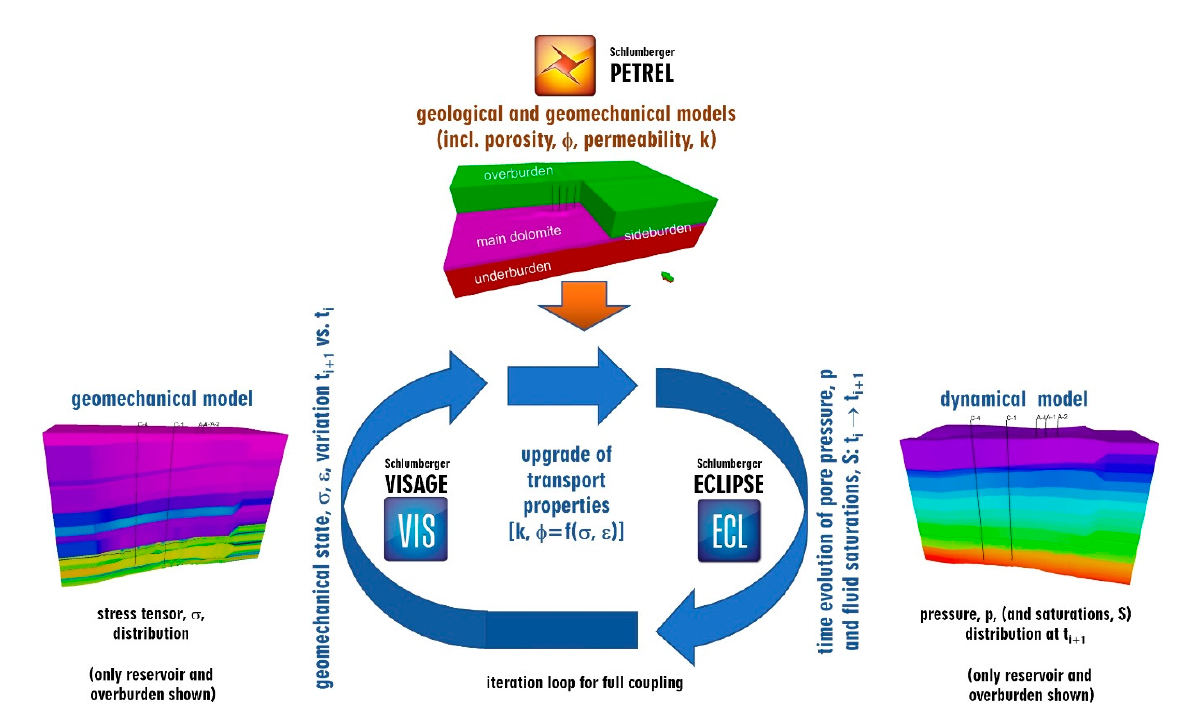
Figure 2. Conventional dynamic and geomechanic model coupling.